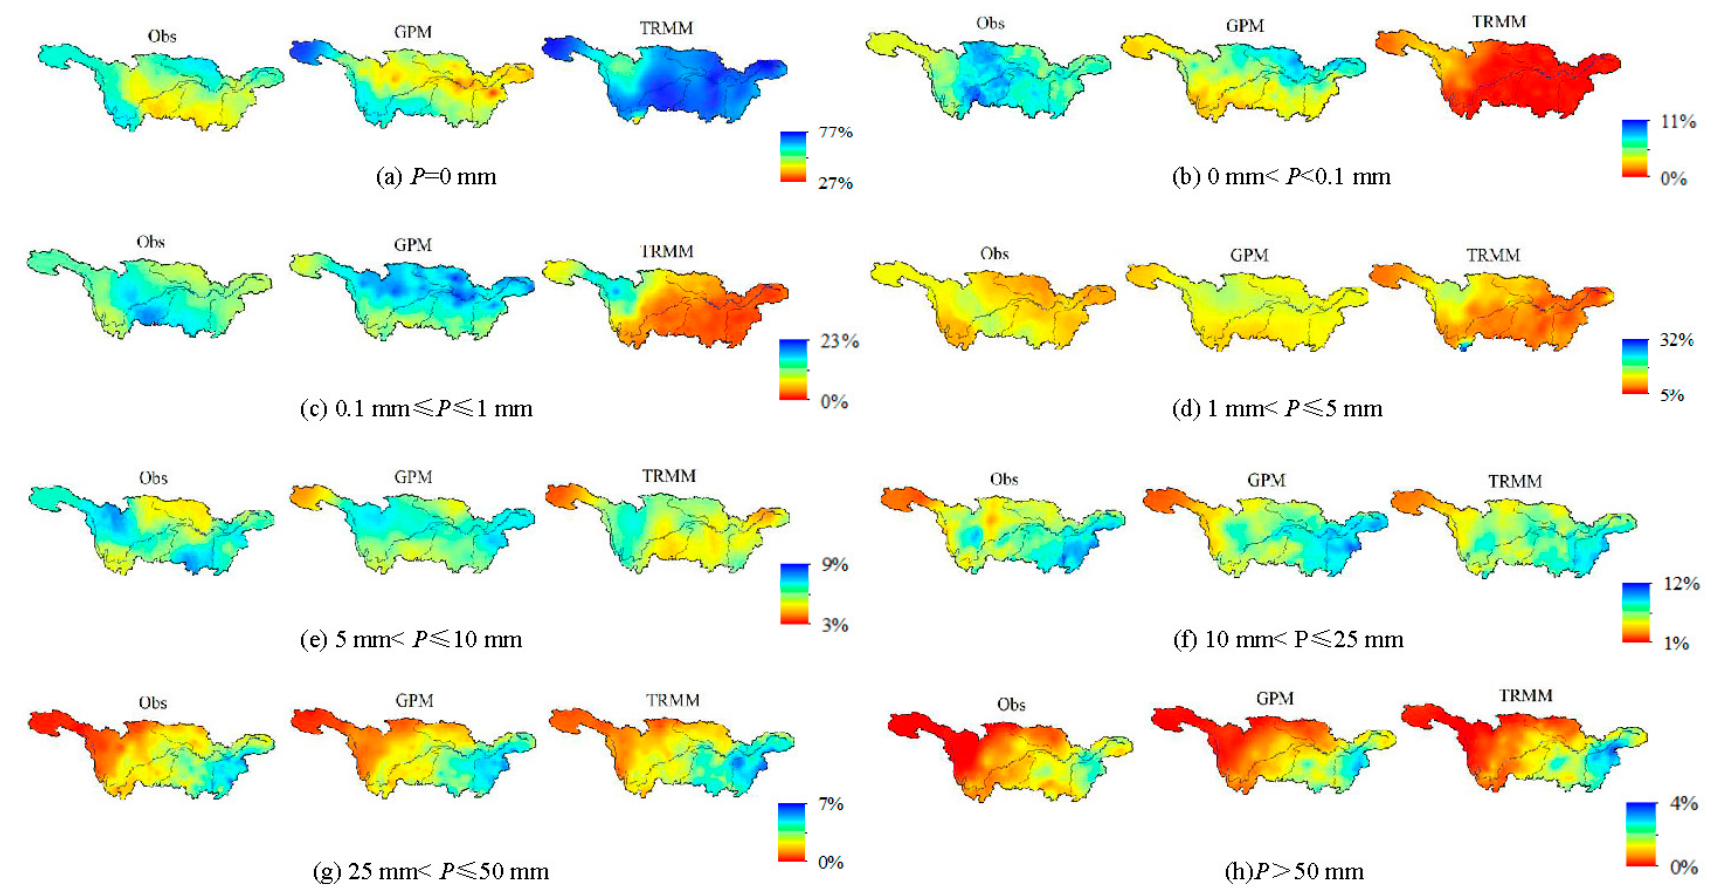
Figure 6. Spatial distribution of different daily rainfall thresholds between rain gauge stations and two satellite-based products during 1 April 2014–31 December 2017. ( a ): P = 0 mm; ( b ): 0 mm < P < 0.1 mm; ( c ): 0.1 mm ≤ P ≤ 1 mm; ( d ): 1 mm < P ≤ 5 mm; ( e ): 5 mm < P ≤ 10 mm; ( f ): 10 mm < P ≤ 25 mm; ( g ): 25 mm < P ≤ 50 mm; ( h ): P > 50